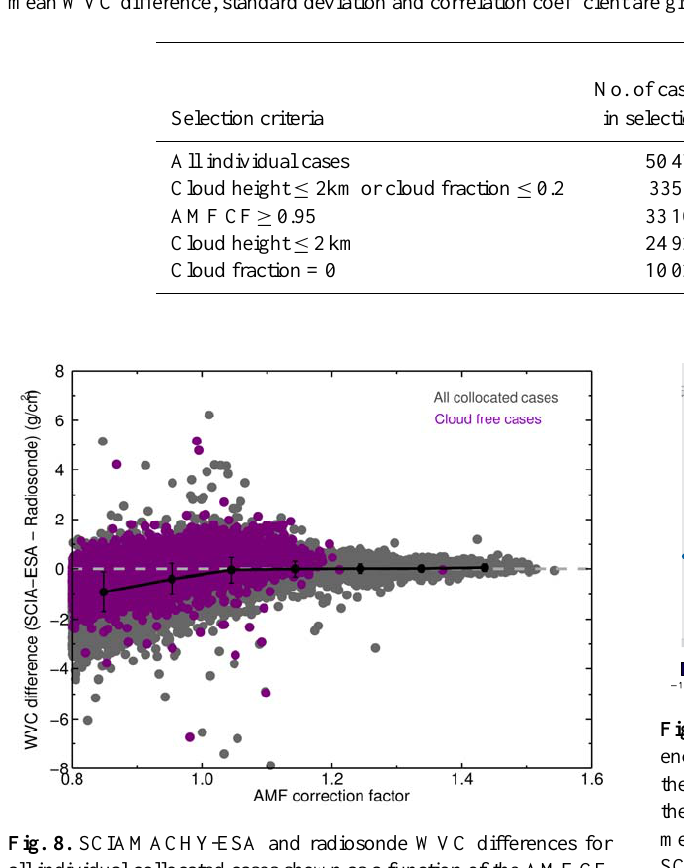
Table 1. Applying various selection criteria on the SCIAMACHY-ESA and radiosonde WVC data sets. The number of cases in selection, mean WVC difference, standard deviation and correlation coefficient are given in each column.